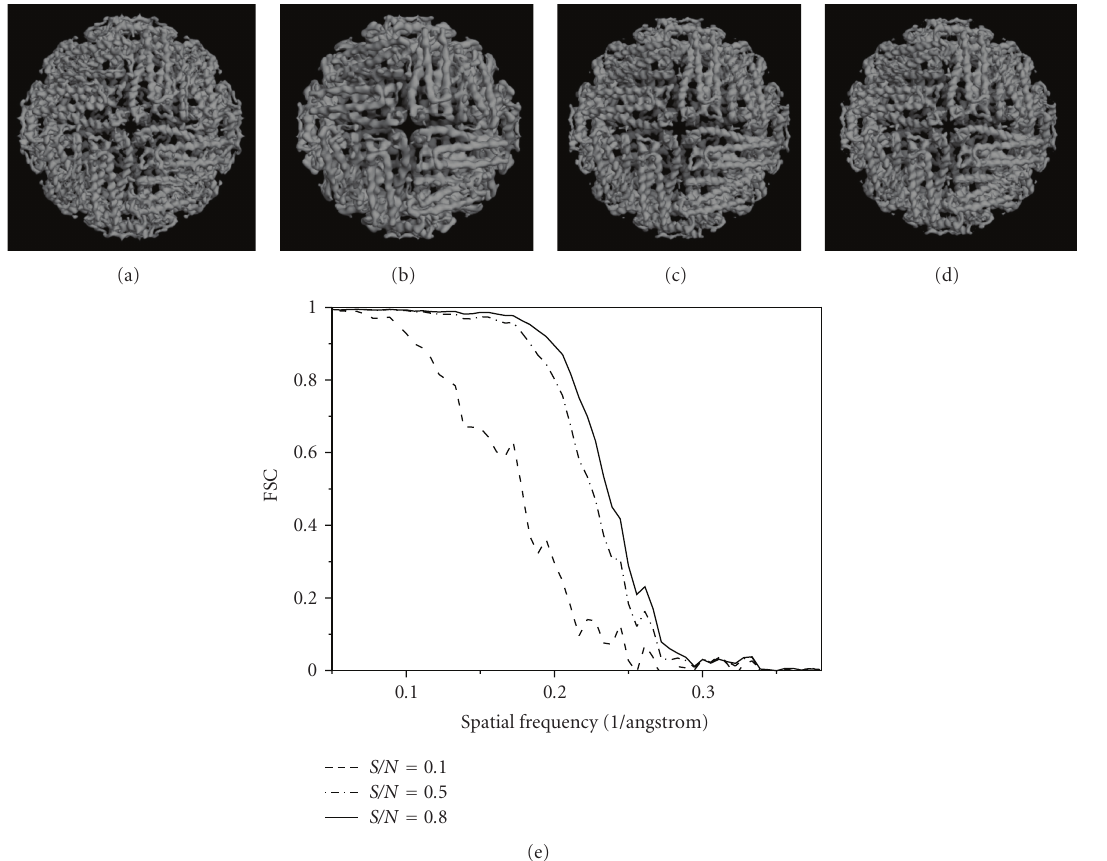
Figure 7: 3D structure viewing along the 4-fold axis of erythrocyte L Ferritin model with S/N = 0 . 1, 0.5, and 0.8. (a) The standard 3D structures, (b) the result for S/N = 0 . 1, (c) S/N = 0 . 5, (d) S/N = 0 . 8, (e) the FSC curves for di ff erent noise levels.